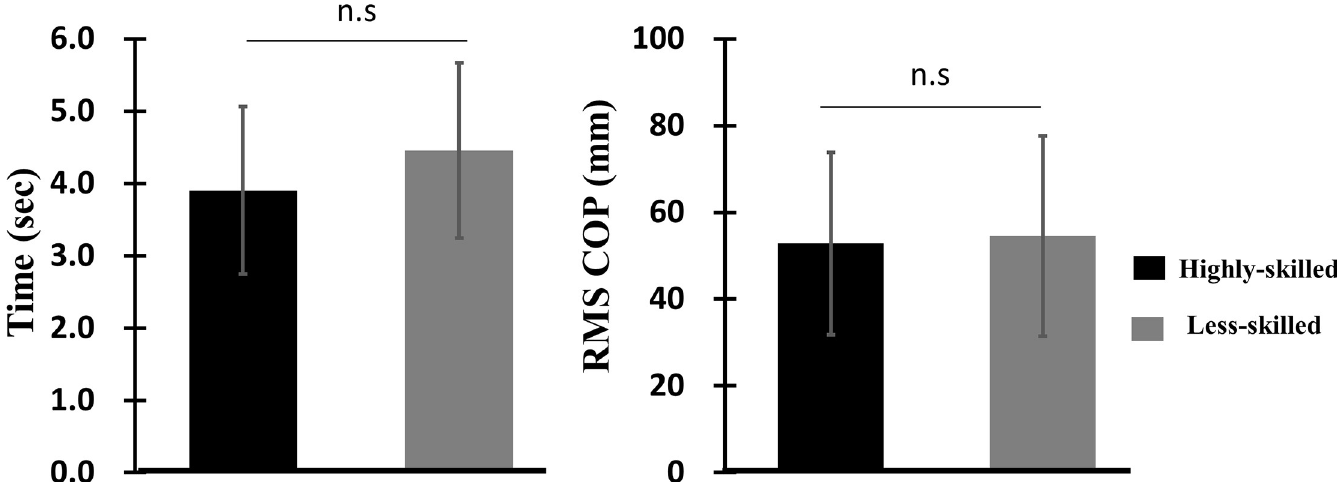
Fig 4. Comparisons of movement time and RMSs of COP fluctuations between highly- skilled and less-skilled during SAPH.